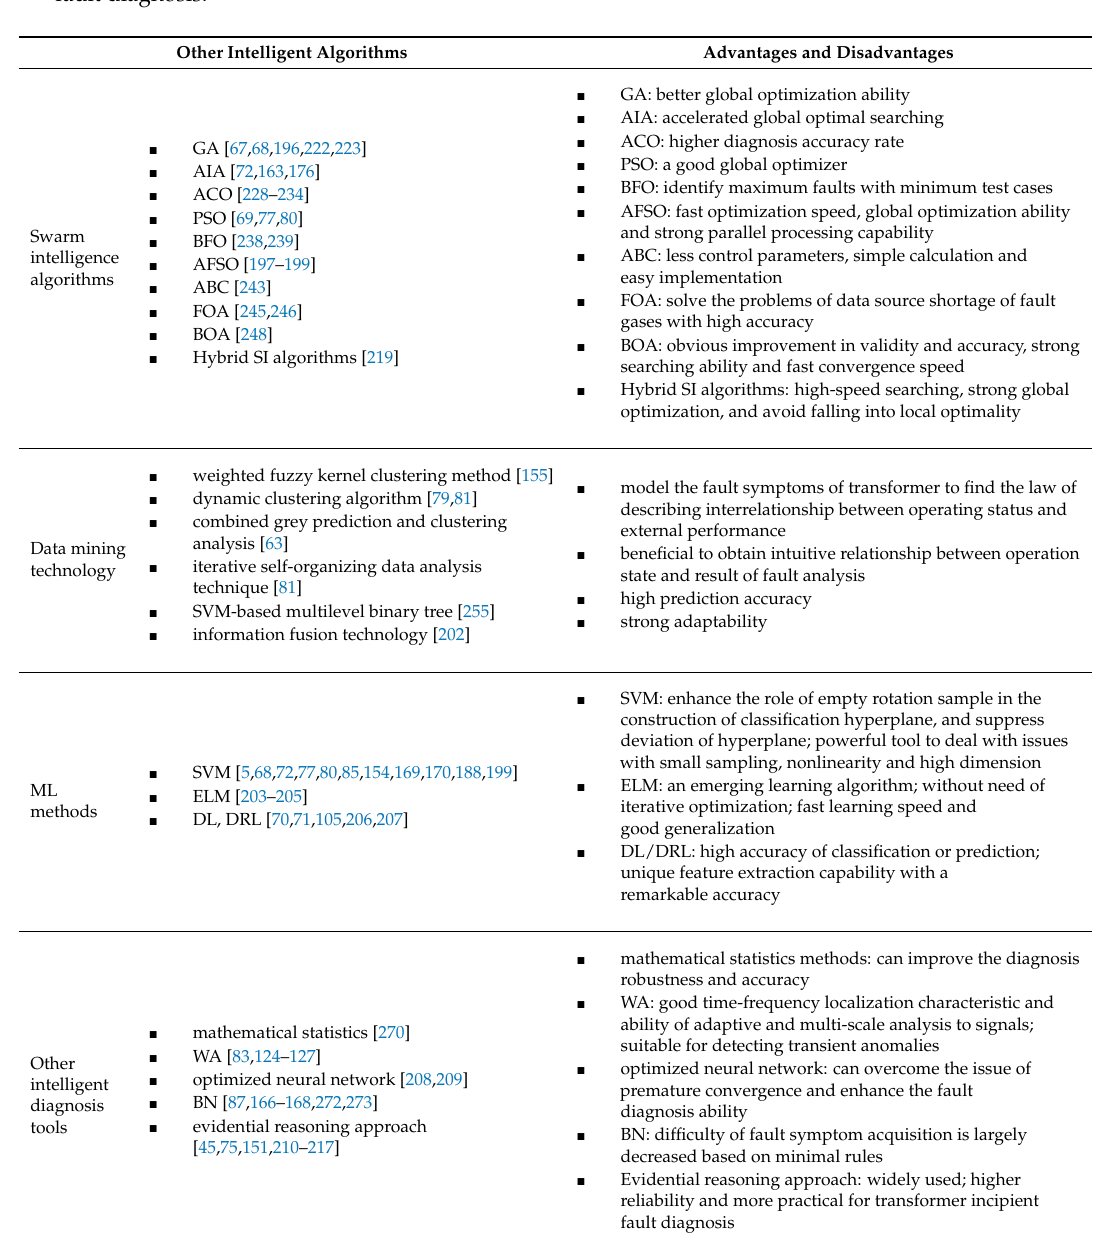
Table 11. A summary for the application of other intelligent algorithms in DGA based transformer fault